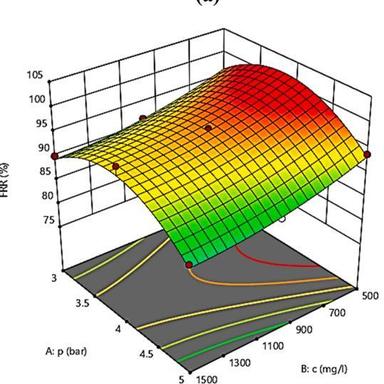
Plots of (a) 3D surface in dark condition; (b) 3D surface in light irradiation; (c) predicted vs. actual values for flux response.